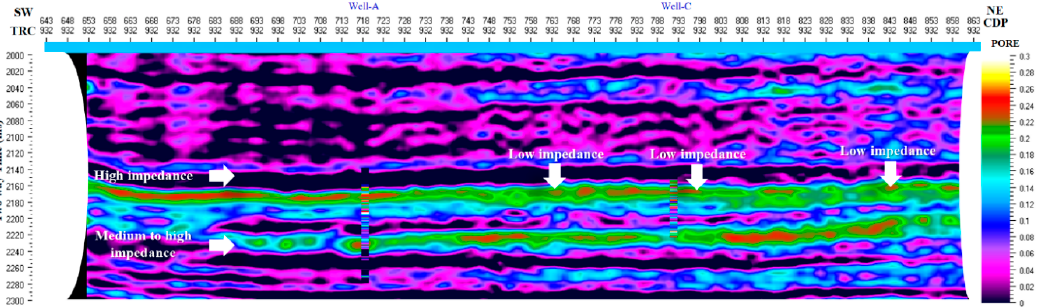
Figure 15. The seismic inversion map of effective porosity for C-sand interval (2140 ms to 2280 ms).